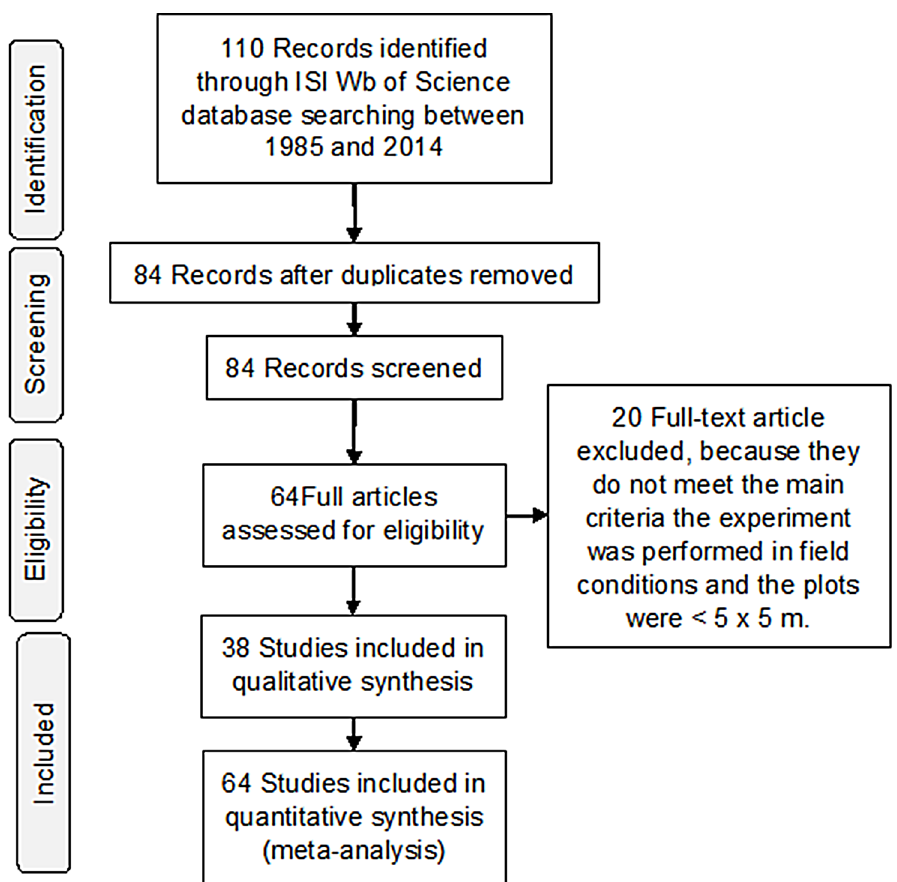
Fig 1. Summary of database searching and inclusion of final groups.